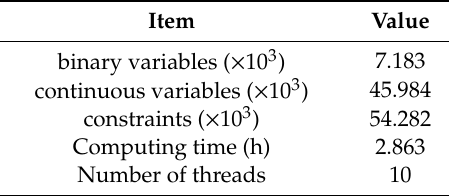
Table 14. Computational issues.